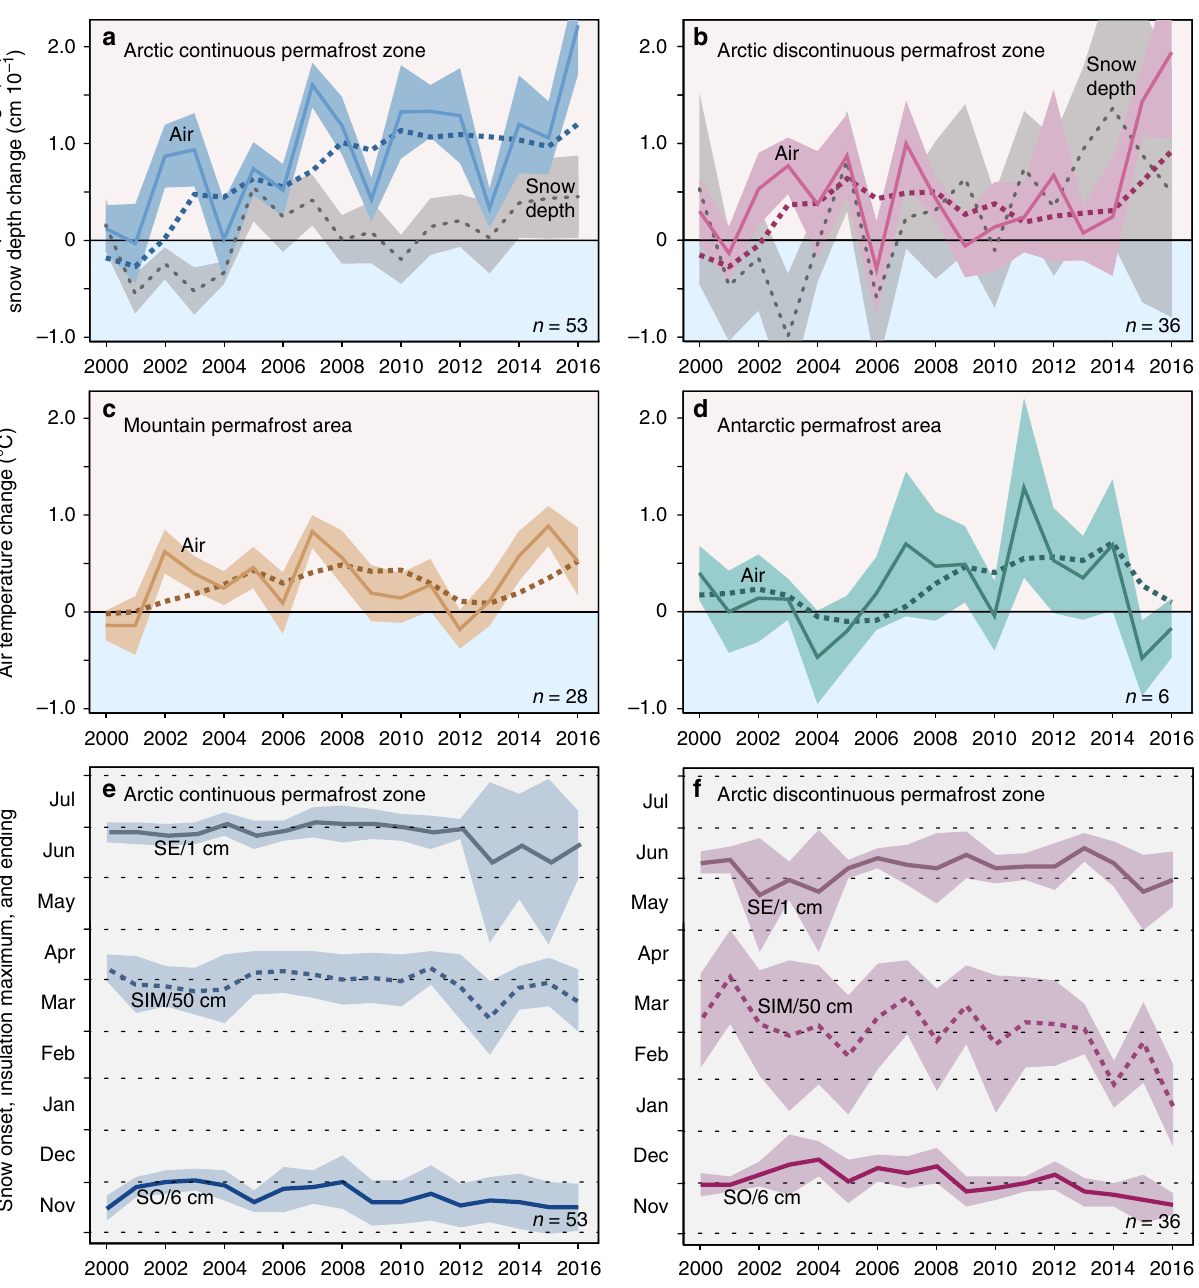
Fig. 4 Annual air temperature and snow depth changes. a – d Air temperature anomaly Δ ^ T y ; b relative to the 1981 – 2010 reference period calculated from mean annual air temperatures at 2-m height above the ground level interpolated from the ERA Interim reanalysis data set. Mean values calculated as de- clustered, indexed area-weighted averages (Eq. 4). Dark colored dashed lines indicate 4-year end-point running means. Snow depth changes Δ ^ S y ; b in a and b , indicated in gray, calculated as the difference relative to the 1999 – 2010 reference period from the CMC reanalysis data set (eq. 5). e , f Onset of snow SO, snow insulation maximum SIM (dashed line), and the end of snow melt SE. Uncertainties are expressed as shading at 95% con fi dence. Sample size n indicates the number of